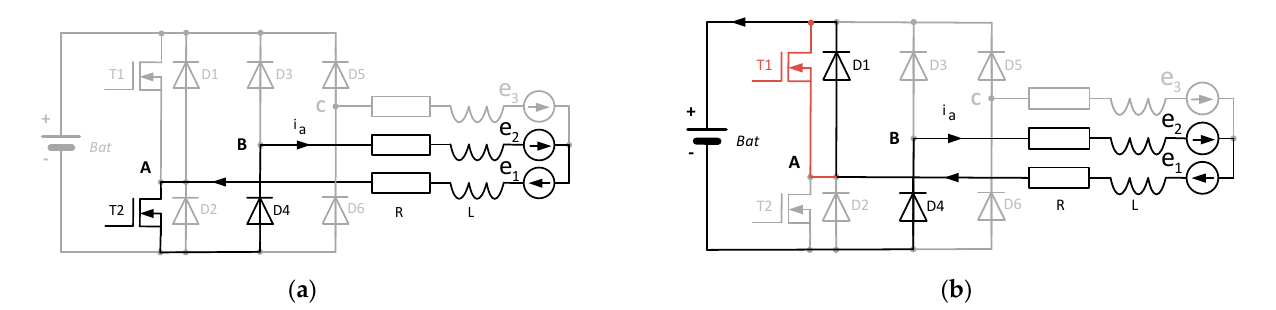
6 of 15 Table 1. Conduction sequences for the sectors. Sector